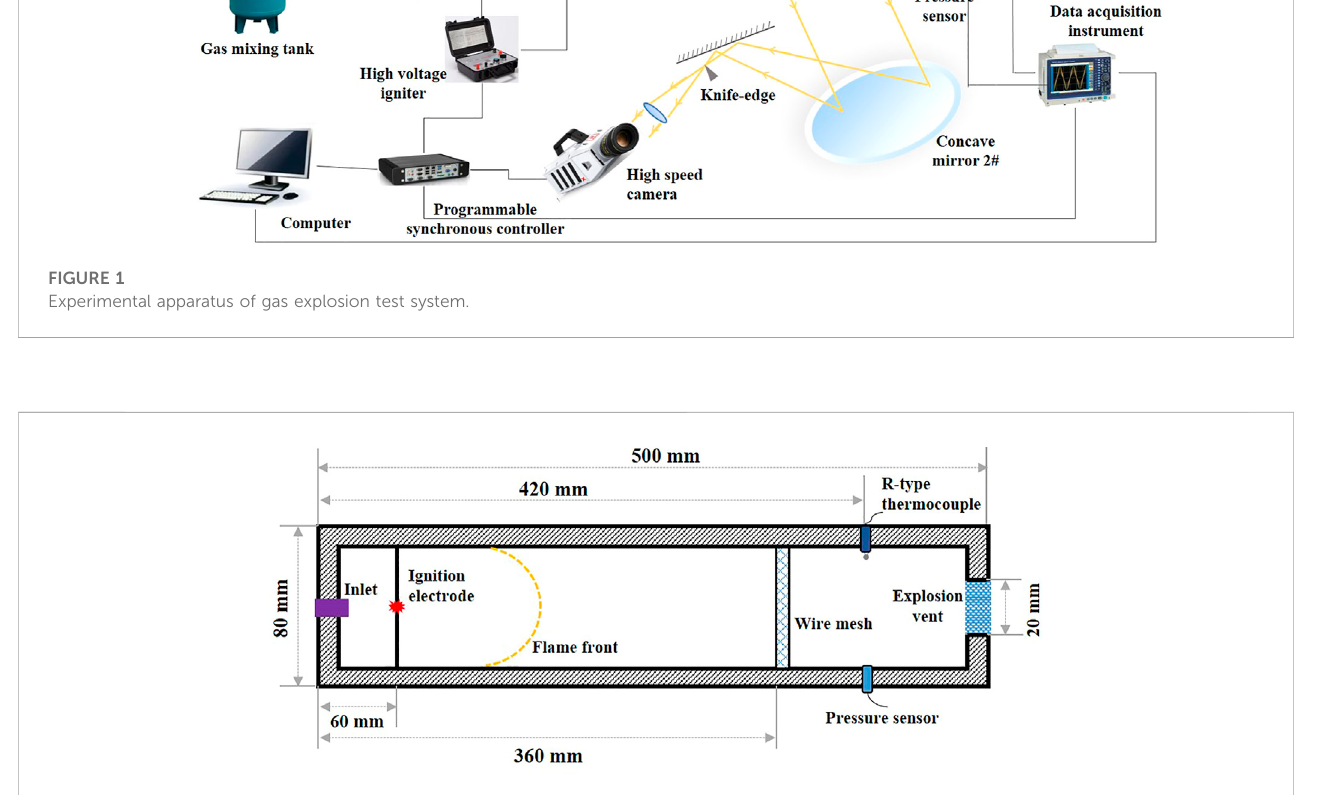
FIGURE 2 Detailed parameter diagram of explosion